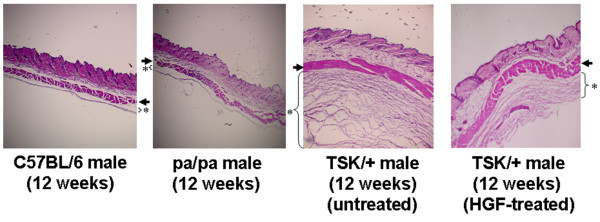
Effect of HGF on skin fibrosis in TSK/+ mice. Skin fibrosis in dorsal skin from C57BL/6, pa/pa, and TSK/+ mice with or without treatment with HGF. Representative histologic sections stained with hematoxylin and eosin are shown (× 40). An asterisk indicates the subcutaneous loose connective tissue layer beneath the panniculus carnosus (arrow). HGF, hepatocyte growth factor; TSK/+, tight skin.